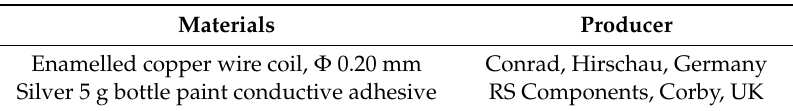
Table 3. List of other materials for textile sensors